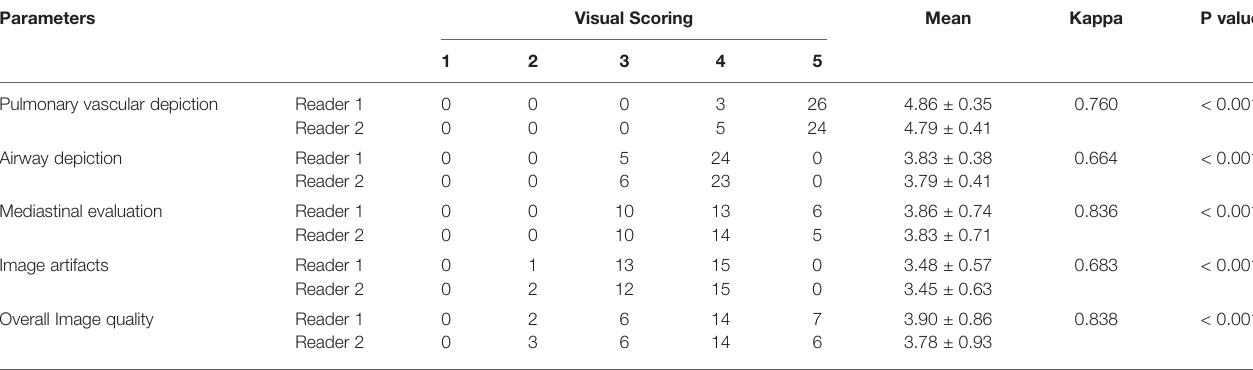
TABLE 1 | Semiquantitative analysis of the image quality of accelerated spiral 3D UTE sequence in 29 patients with breast cancer.